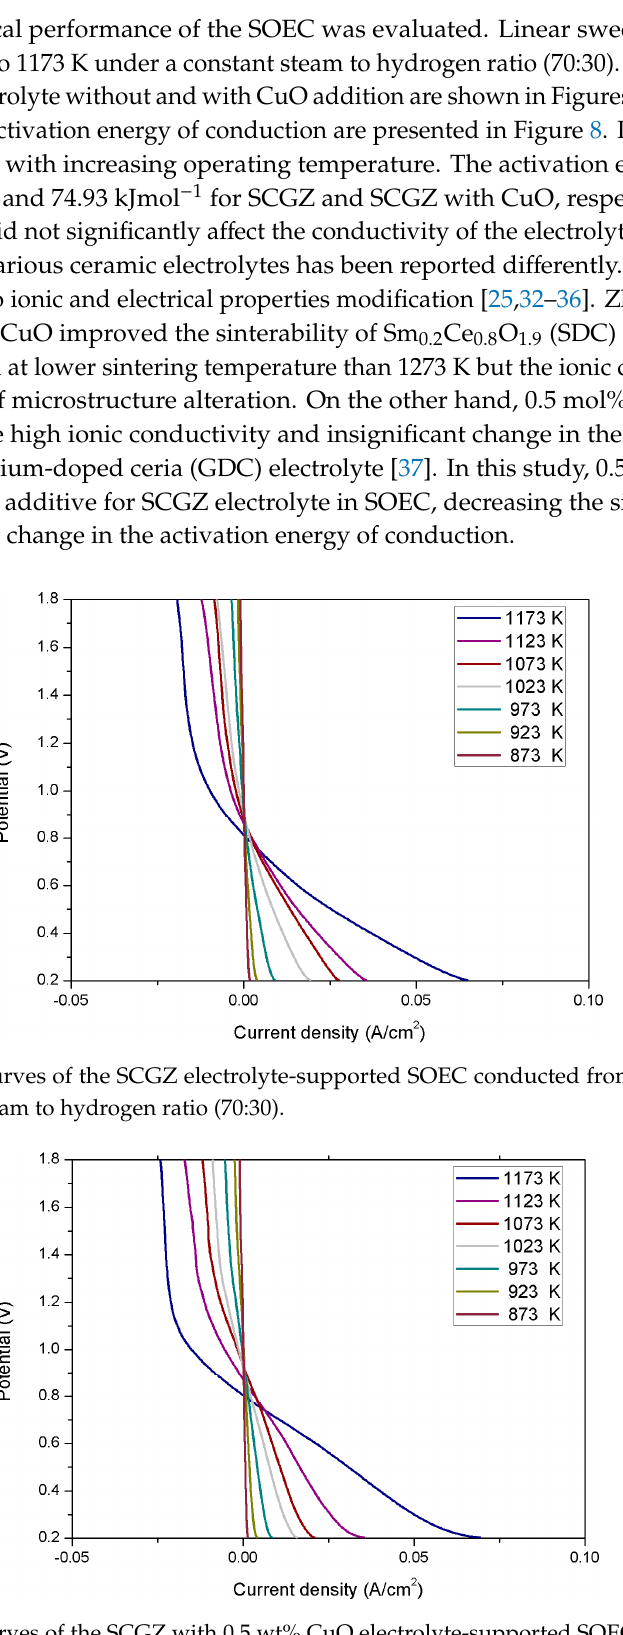
Figure 5 . The X - ray diffraction patterns of ( a ) sintered SCGZ at 1673 K and ( b ) sintered SCGZ with 0.5 wt% CuO at 1523 K .